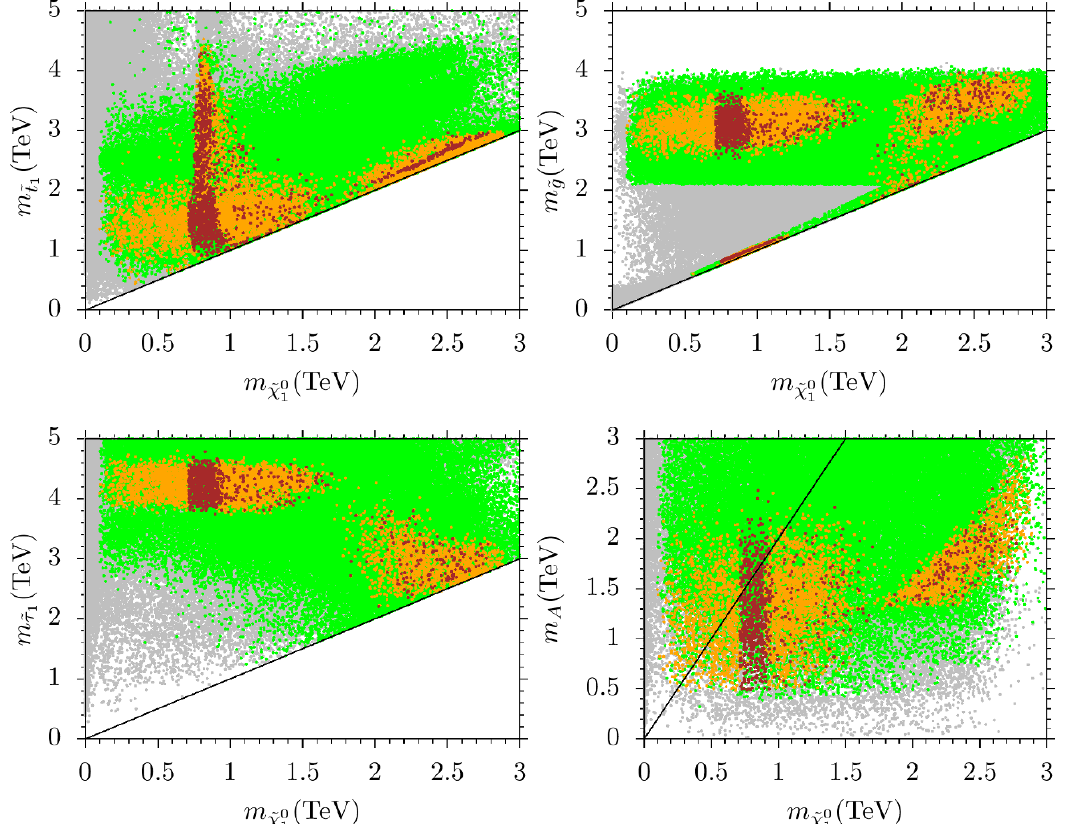
Figure 6 . Plots in the m ~ same as in (cid:12)gure 4. In addition, the Higgs boson mass bound is also applied. The diagonal lines in the (cid:12)rst three plots indicate the mass degeneracy between the particles, while in the m A (cid:0) m plane, the diagonal line indicates the regions where m A = 2 m